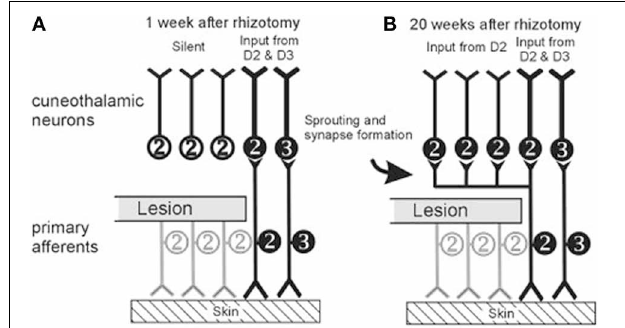
FIGURE 4 | Schematics represent hypothesized effects of a dorsal rootlet section that blocks sensory input from digit 1 (thumb) and digit 2 (index finger) in a macaque monkey after 1 week (A) and after 20 weeks (B). Inputs from digits 1 and 2 are labeled together as 2. After cutting the dorsal rootlet, some fraction of neurons innervating digits 1 and 2 may be spared, but a population of cuneate (and dorsal horn) neurons will be left without peripheral input. By 20 weeks after the dorsal rootlet section, terminals of the spared neurons innervating digits 1 and 2 have sprouted collaterals to innervate the previously deafferented target neurons in the cuneate nucleus. Similar mechanisms are hypothesized to occur at all levels of processing hierarchy from the brainstem to cortex. (From Darian-Smith, 2004, Figure 10, Copyright©2004 Wiley-Liss, Inc.. Reprinted with permission from John Wiley & Sons).